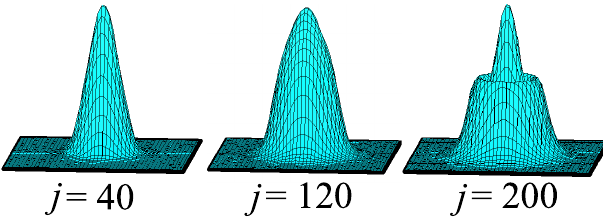
FIG. 8. (Color) Optical field amplitude j a (cid:3) x; y (cid:5)j at the output mirror for several values of current density j . Mode distortion is more apparent as the current density is increased.